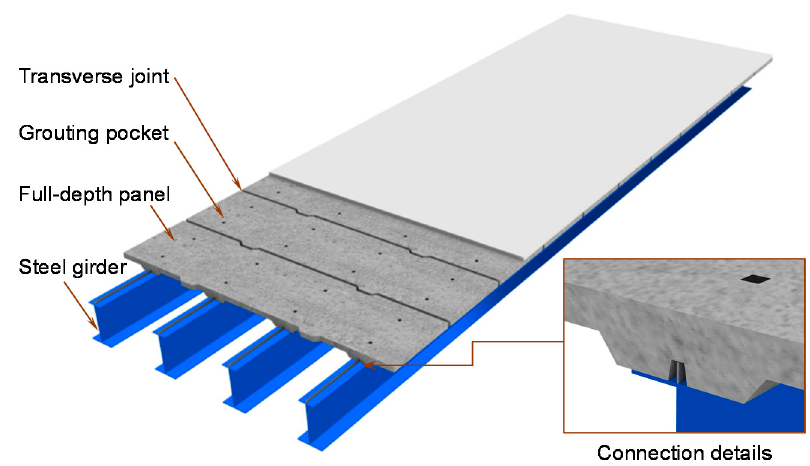
Figure 21. Schematic of the prototype bridge.